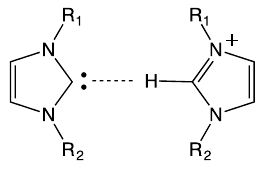
Figure 9. NHC–NHCH + dimer.